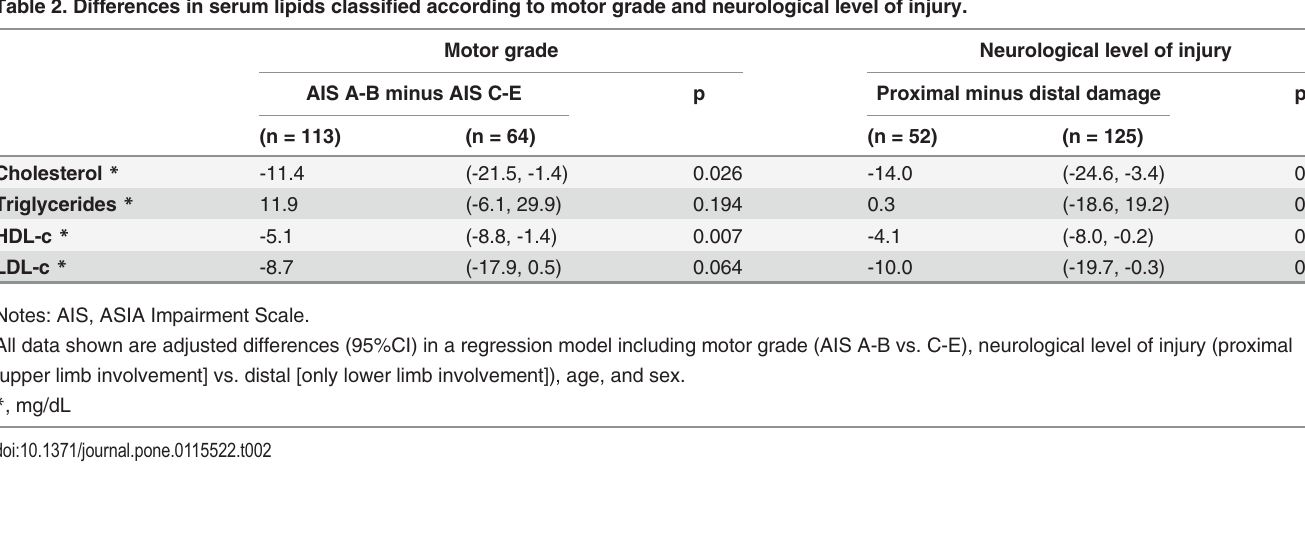
(-19.7, -0.3) mg/dL] compared with those with distal damage (only lower limb involvement) (all p < 0.05, Table 2). A more detailed analysis considering cervical, thoracic, and lumbo-sacral cases separately revealed that the main differences were present at the cervico-thoracic transi- tion (Table 3). Statistically significant differences in total cholesterol, HDL-c, and LDL-c were also found when comparing patients with the most severe condition (AIS A-B individuals with proximal damage) with those with the closest-to-normal condition (individuals with an AIS C- E score and only distal damage) (Table 4). After adjusting for age, there was no significant relationship between serum lipid values and time since injury, whether stratified into 5-year groups or collapsed into a dichotomous vari- able of below or above than 10 years (S1 Table).